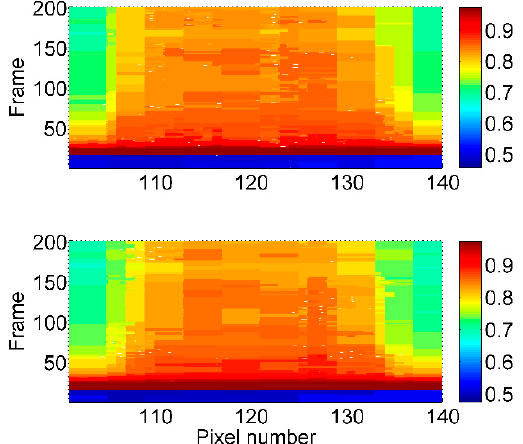
Figure 9. Pixel intensity variation along lines 73 (top) and 80 (bottom). Figure 10 . Pixel intensity variation along lines 73 (top) and 80 (bottom). Figure 10 . Pixel intensity variation along lines 73 (top) and 80 (bottom).